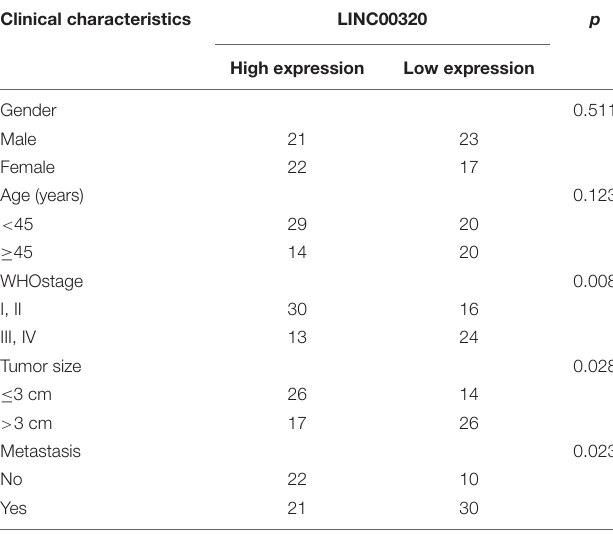
TABLE 4 | Relationship between the expression of LINC00320 and clinical characteristics of patients with glioma. Clinical characteristics